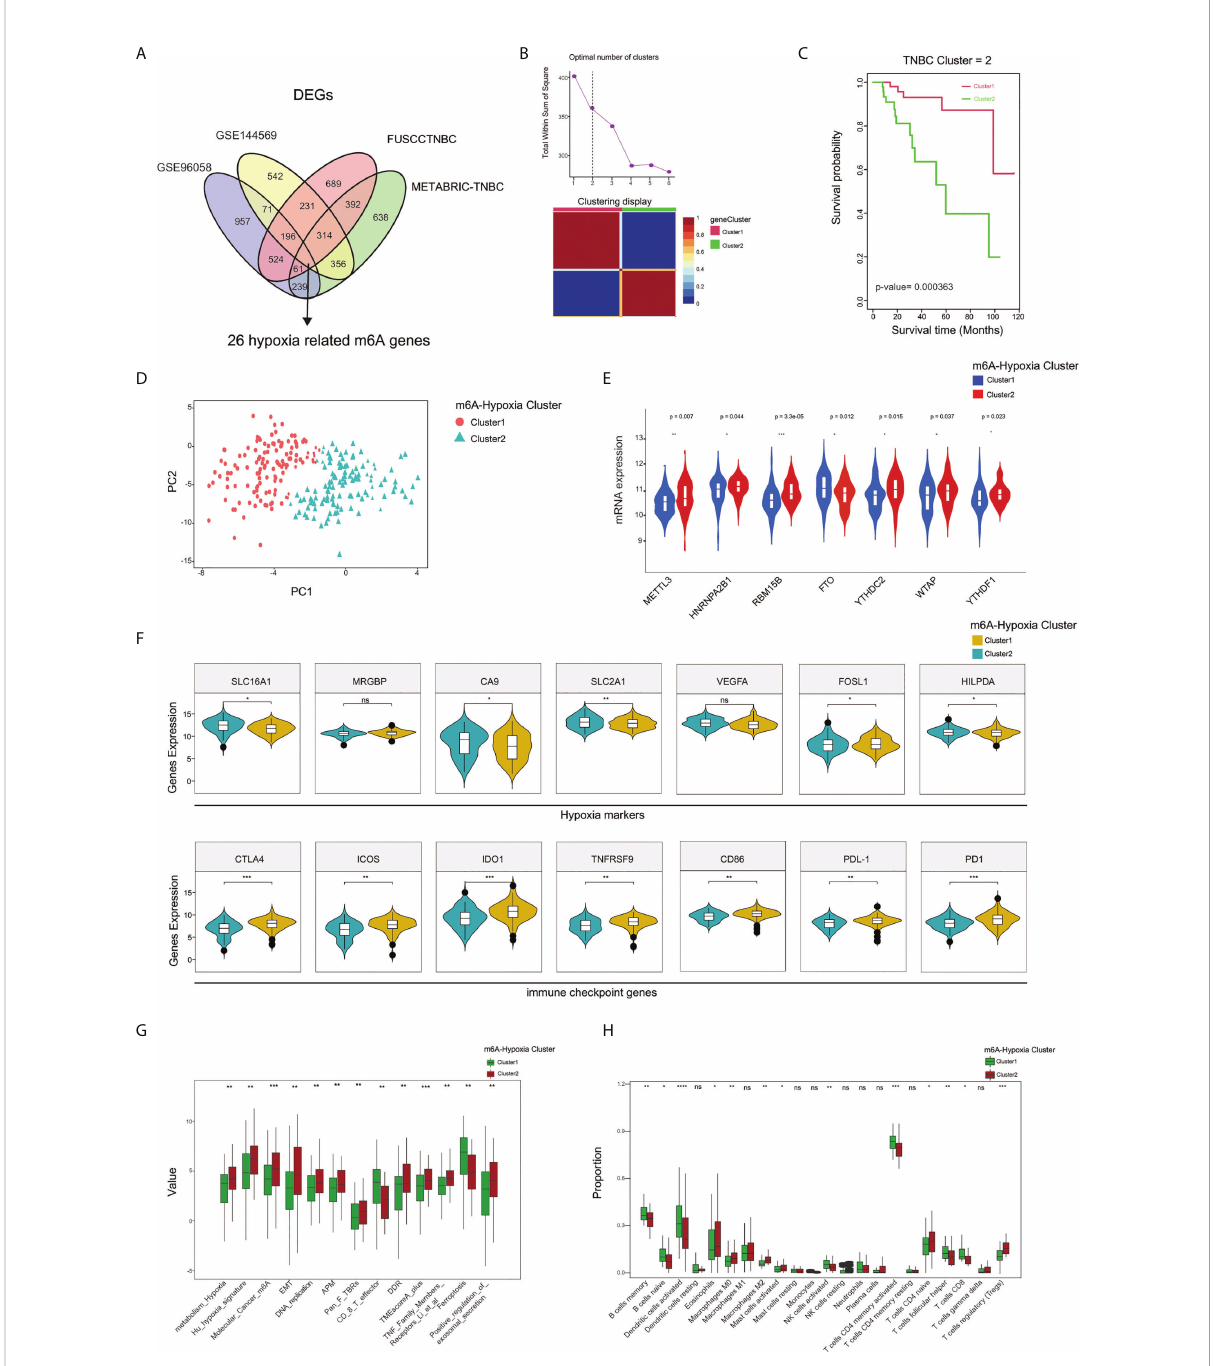
FIGURE 5 Characterization of 2 m6A-hypoxia clusters based on m6A-hypoxia related genes. (A) The Venn diagram indicating 26 m6A-hypoxia related genes identi fi ed in four TNBC cohorts. (B) Calculation number of optimal cluster and characterization of gene clusters performed by NMF method. (C) The overall survival analysis of m6A-hypoxia clusters. (D) Two gene clusters by Principal component analysis. (E) Comparing the expression of m6A regulators between m6A-hypoxia cluster1 and cluster2. (F) Comparison of hypoxia markers and immune checkpoint genes expression among 2 clusters. (G) Comparison of the TME and immune related signatures of 2 clusters. (H) Comparison of the immune in fi ltrated cells among different gene clusters. (*P < 0.05,**P < 0.01, ***P < 0.001, and ****P < 0.0001). ns, not signi fi